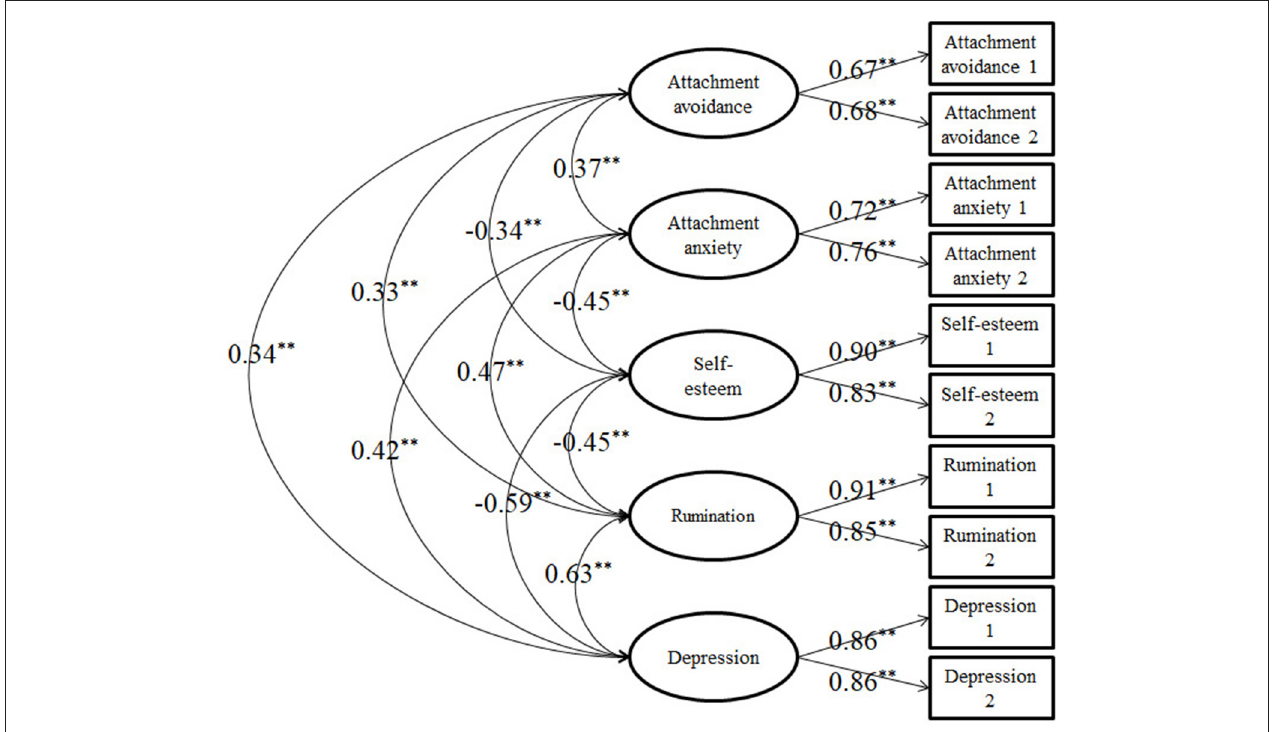
FIGURE 2 | Measurement model. ** P <